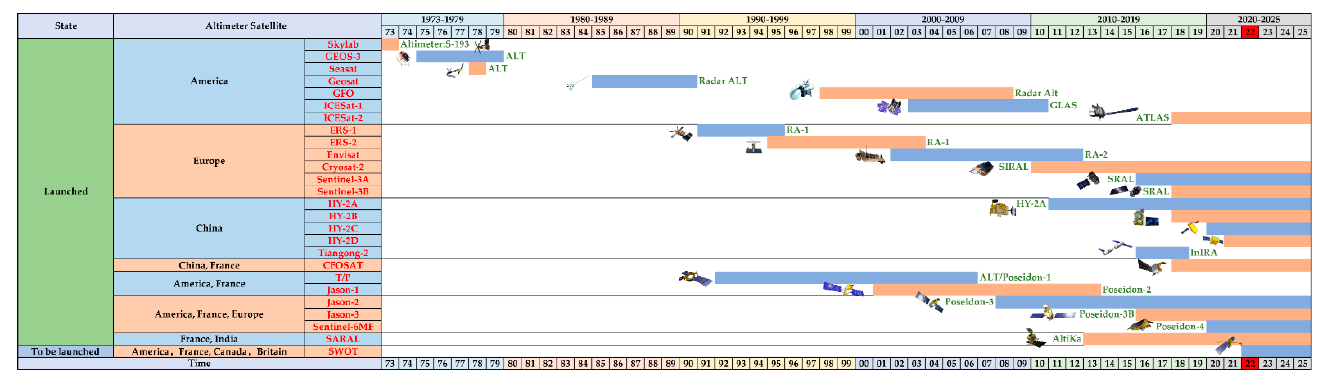
Figure 2. Diagram of the development process of altimetry satellites. Table 1. The development process of satellite altimetry.